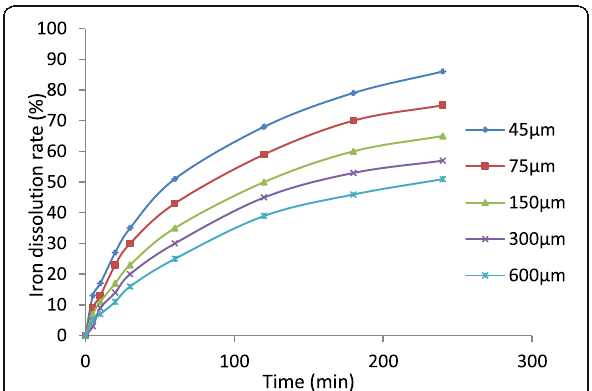
Fig. 1 Effects of ore particle sizes on the dissolution rate of